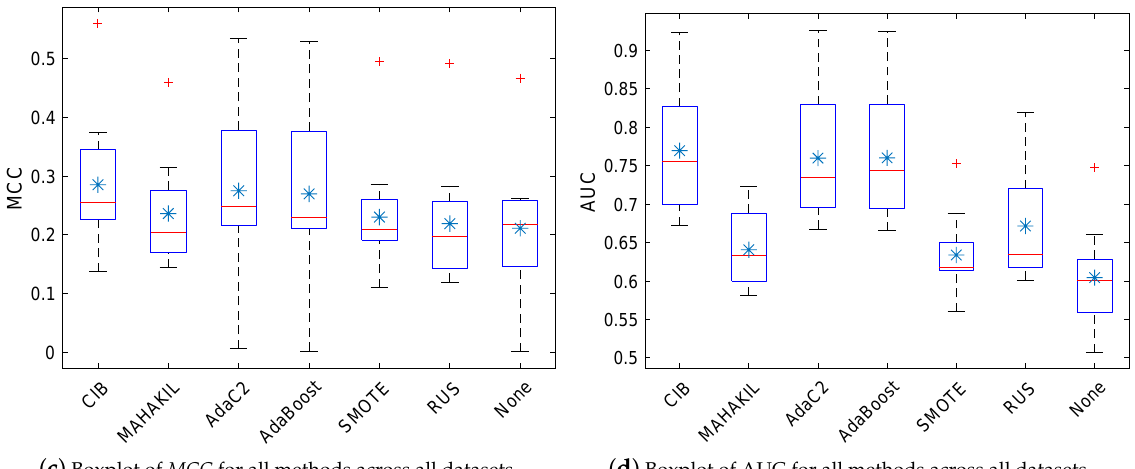
( c ) Boxplot of MCC for all methods across all datasets. ( d ) Boxplot of AUC for all methods across all datasets. Figure 2. Boxplot of F 1 , AGF, AUC, and MCC across all NASA datasets for our CIB and the baselines. The horizontal line in the box denotes median and the asterisk indicates mean value.